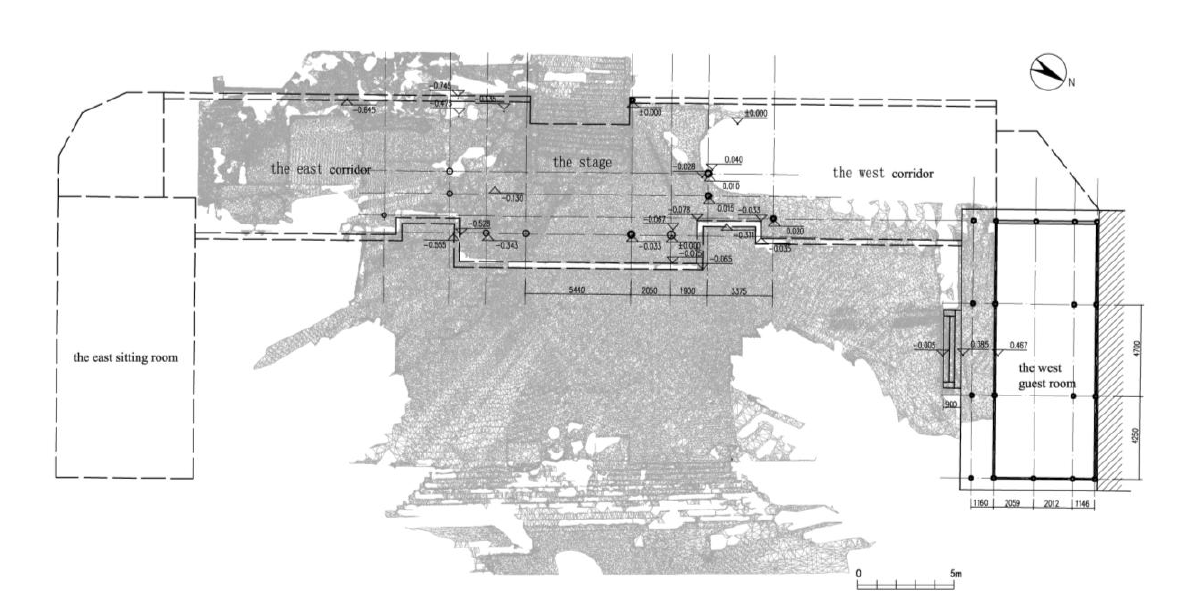
Figure 1. 3D laser scanning for the stage